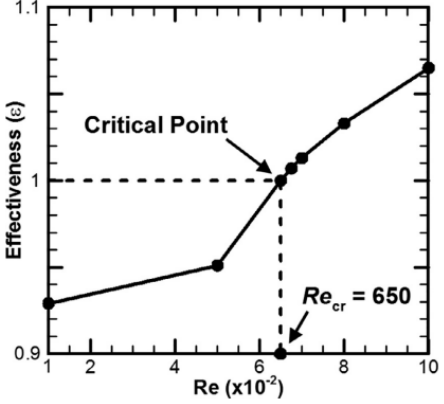
Figure 15. Dependence of heat transfer effectiveness on Reynolds numbers. Reprinted with permis- sion from Ref. [36]. 2021, Elsevier.